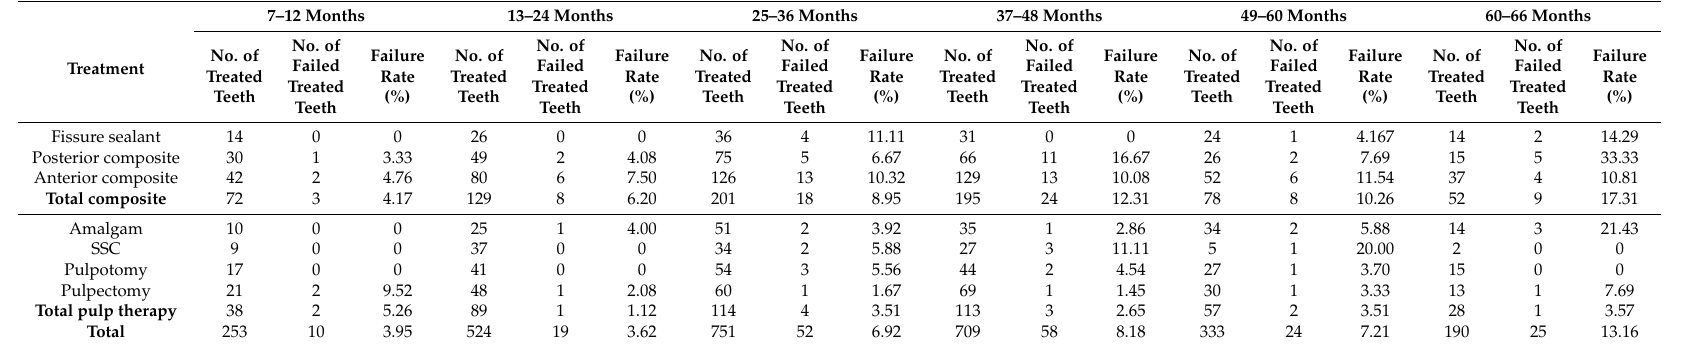
Table 3. Failure rate of each treatment modality based on follow-up